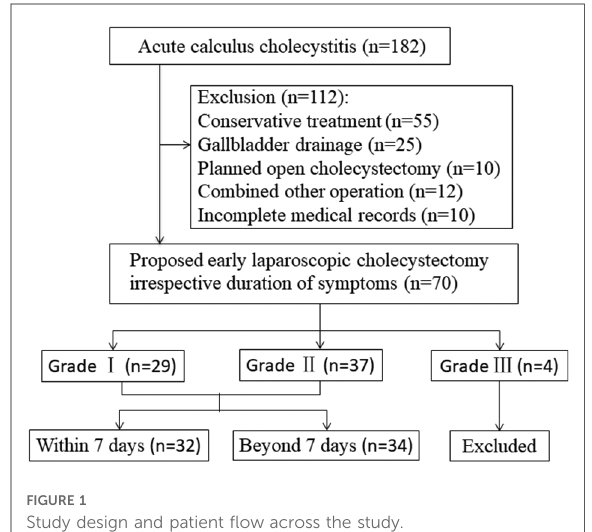
FIGURE 1 Study design and patient fl ow across the